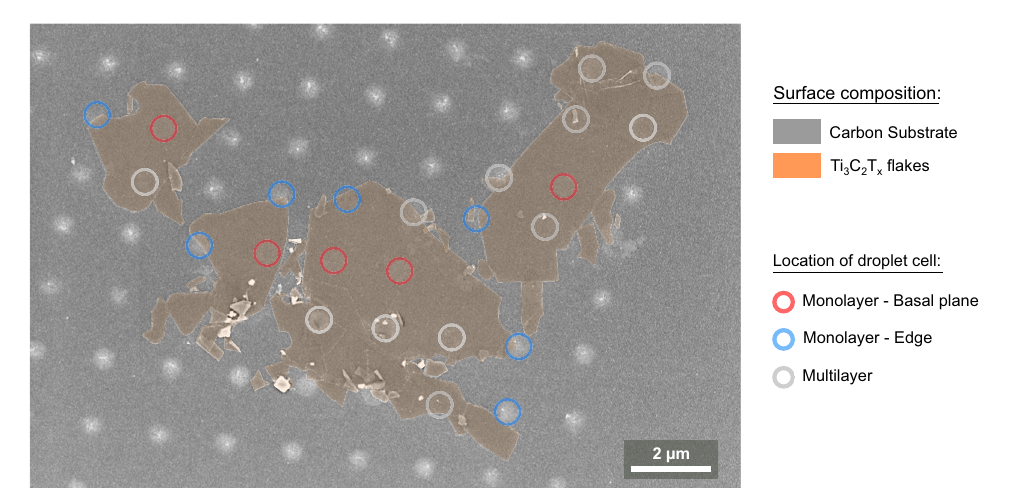
endofSECCMprobe,highlightingthenanoscaleelectrochemicaldropletcellatthe end oftheSECCM probe and thetwo-electrode electrochemicalcellcon fi guration. c Electron micrograph of sample surface containing monolayer MXene immobi- lized on a carbon surface after SECCM measurements, with each SECCM sample location highlighted according to the surface